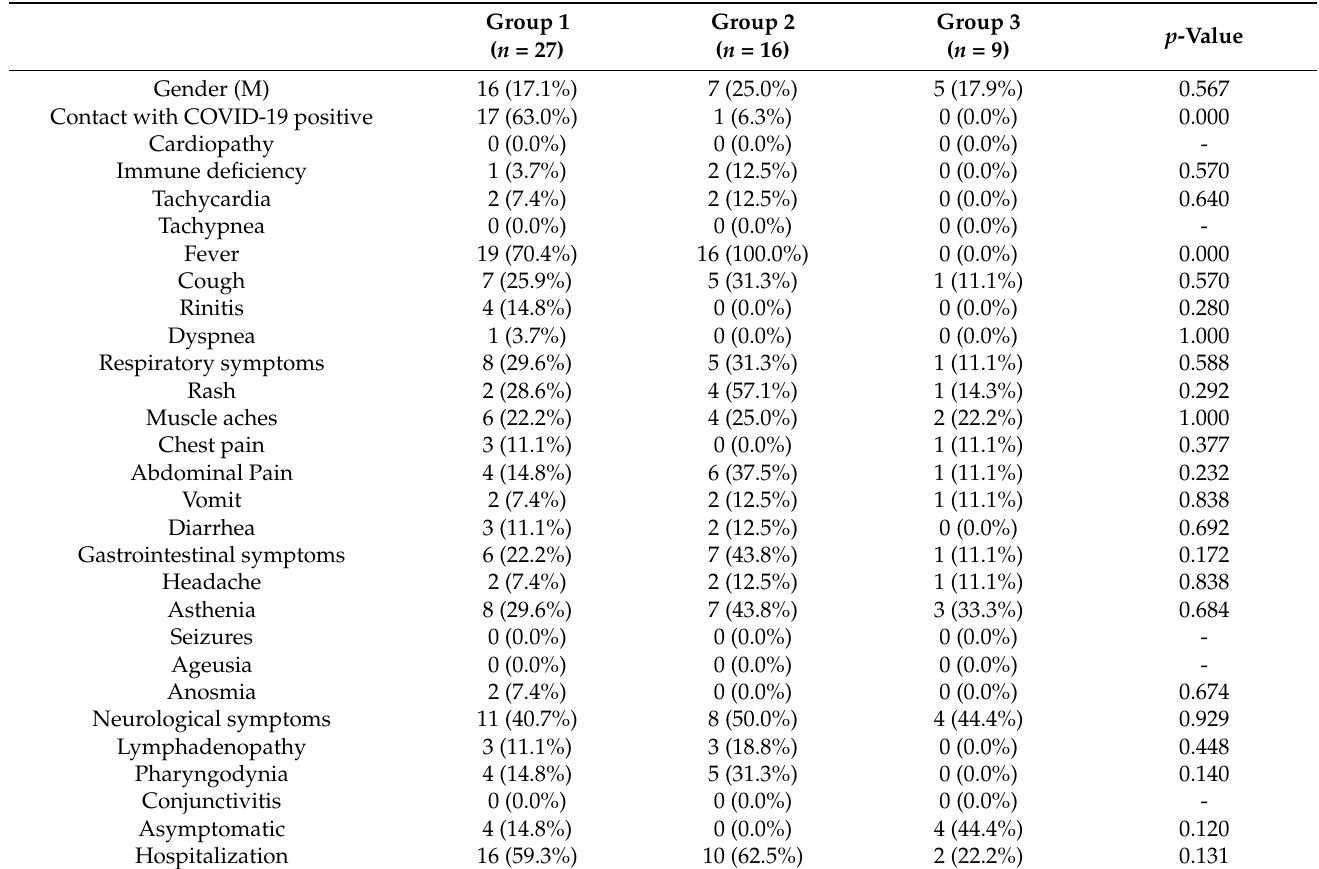
Table 1. Characteristics and clinical symptoms of the study population ( N =